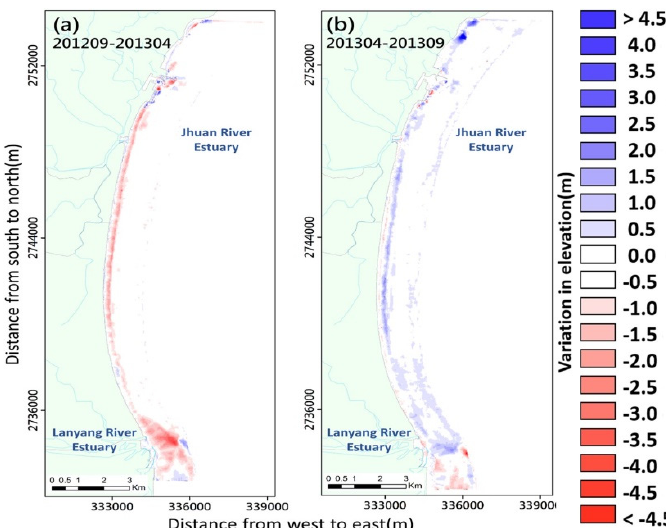
Figure 8. The spatial distribution of seasonal variability for erosion and accretion along the shoreline for ( a ) winter (from September 2012 to April 2013) and ( b ) summer (from April 2013 to September